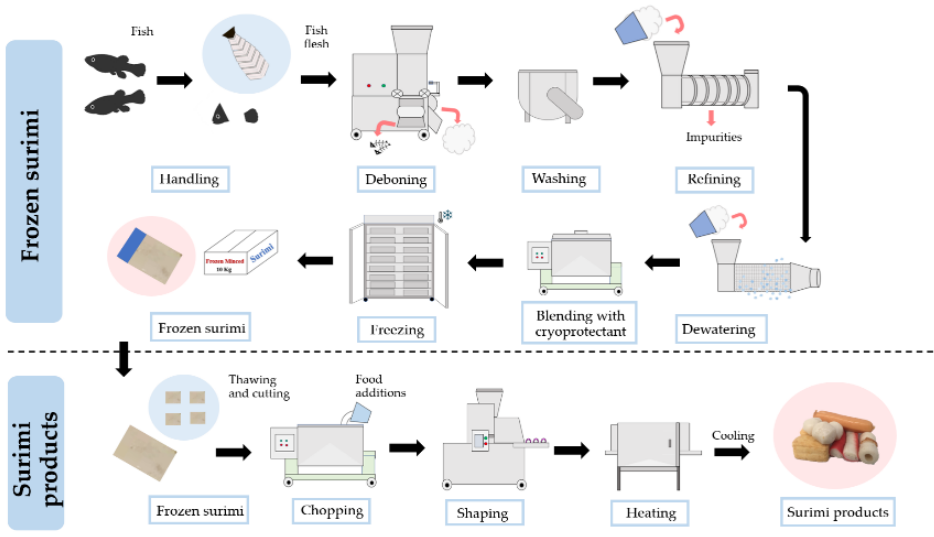
Figure 2. The basic processing of frozen surimi and surimi products.